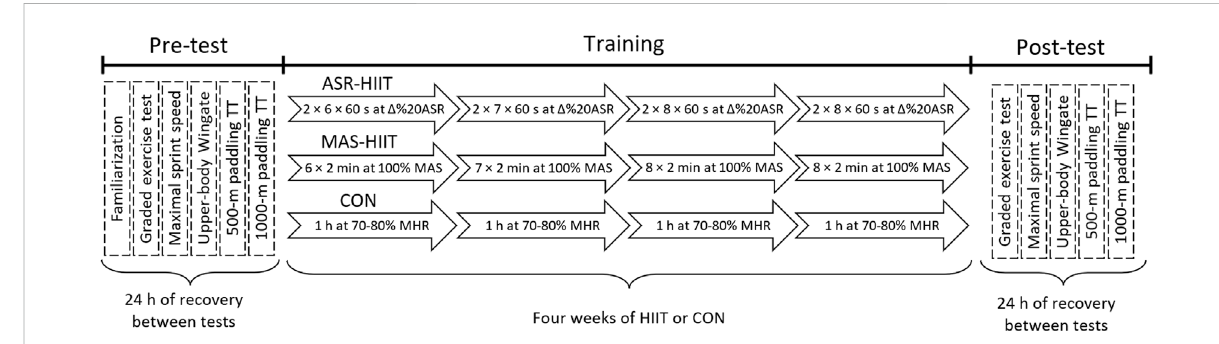
FIGURE 1 Overview of experimental protocol. HIIT, high-intensity interval training; ASR-HIIT, HIIT as a proportion of anaerobic speed reserve; MAS-HIIT, HIIT based on maximal aerobic speed, CON, traditional endurance paddling; MHR, maximum heart rate; TT, time trial. Boxes denote number, duration, and intensity of HIIT completed over a 4 week